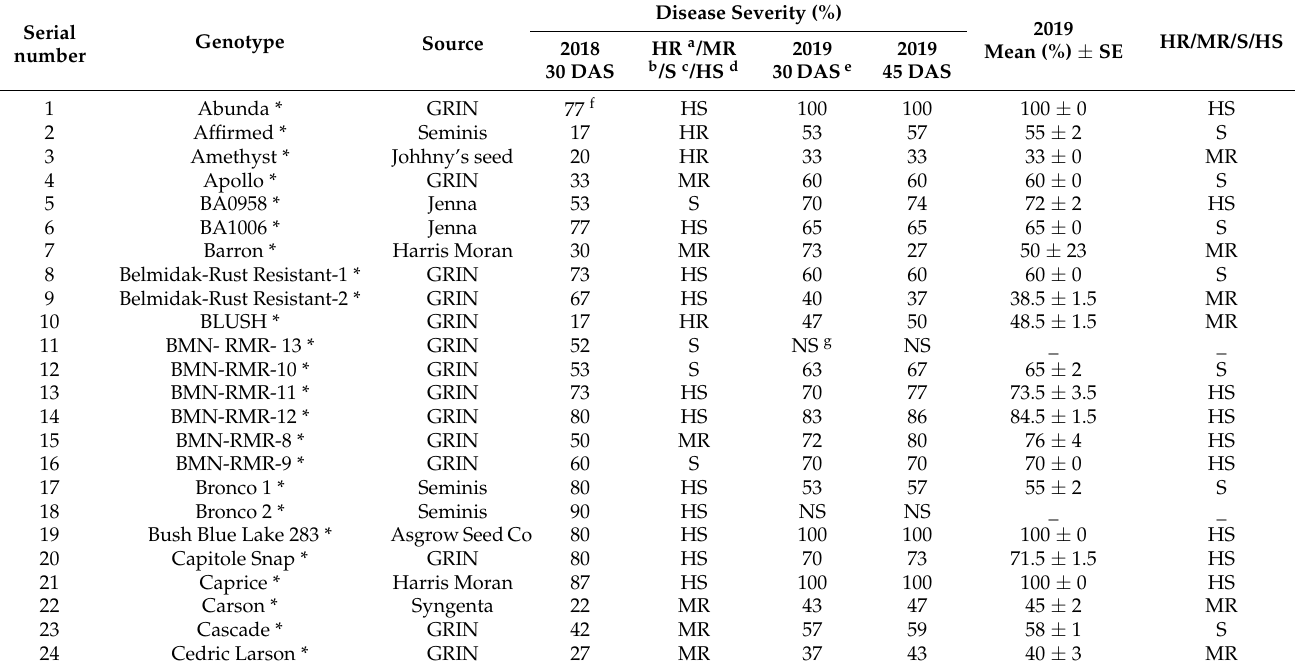
Table 1. Response of Phaseolus genotypes to leaf crumple disease in the field during 2018 and 2019 cropping seasons. Serial